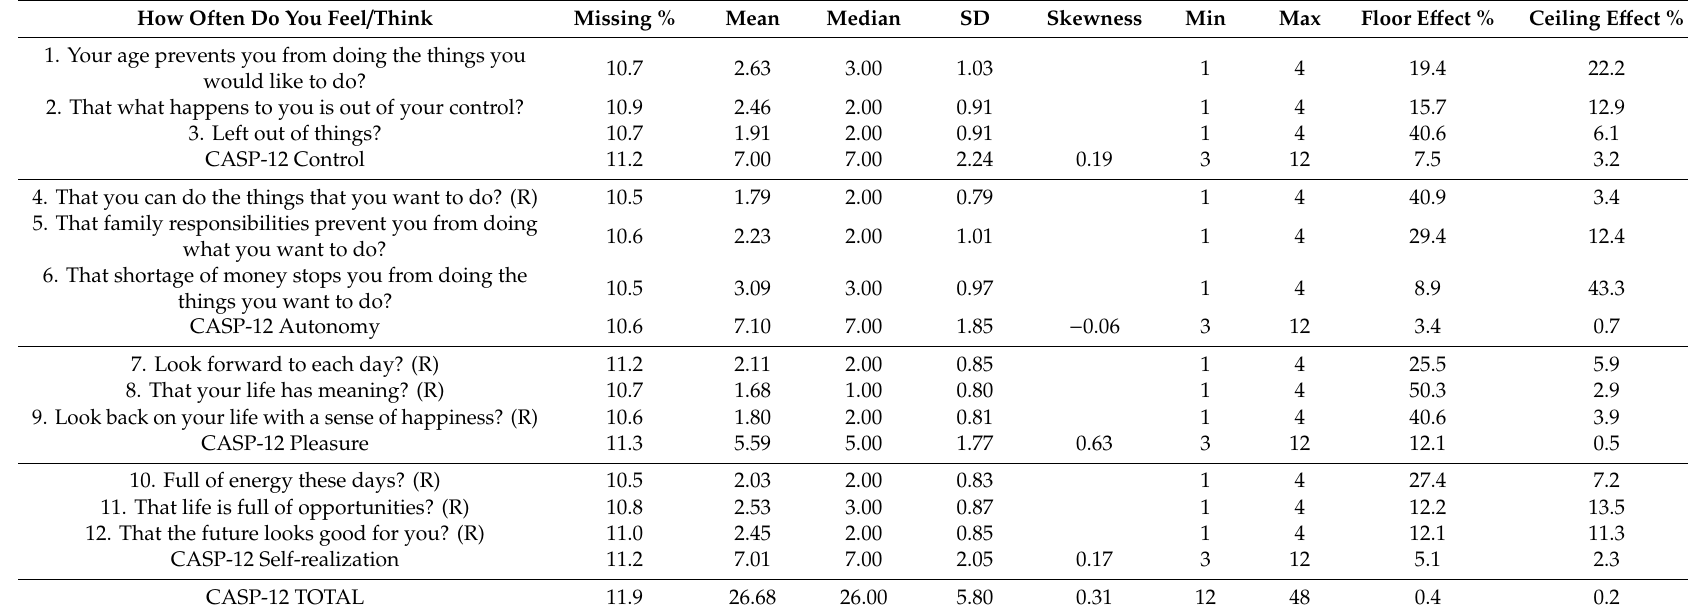
Table 2. Data quality and acceptability of